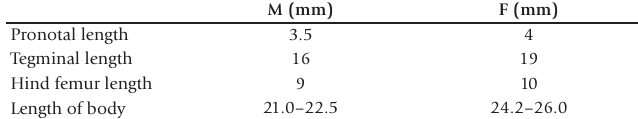
Table 1. Body dimensions of Culmulus stramineus .